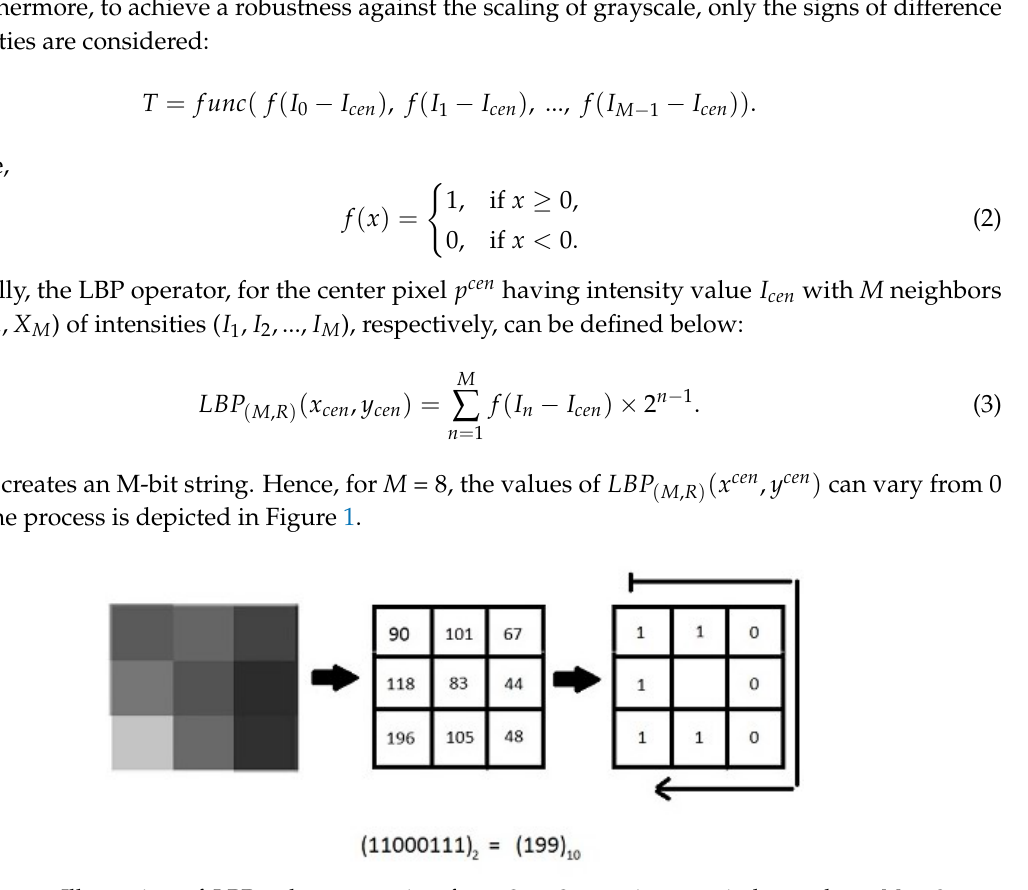
Figure 1. Illustration of LBP value generation for a 3 × 3 gray image window, where M = 8, and radius =